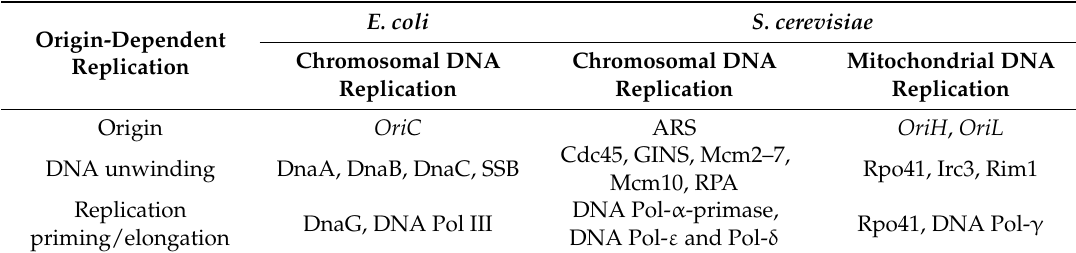
Table 1. Factors required for origin-dependent DNA replication initiation in Escherichia coli and Saccharomyces